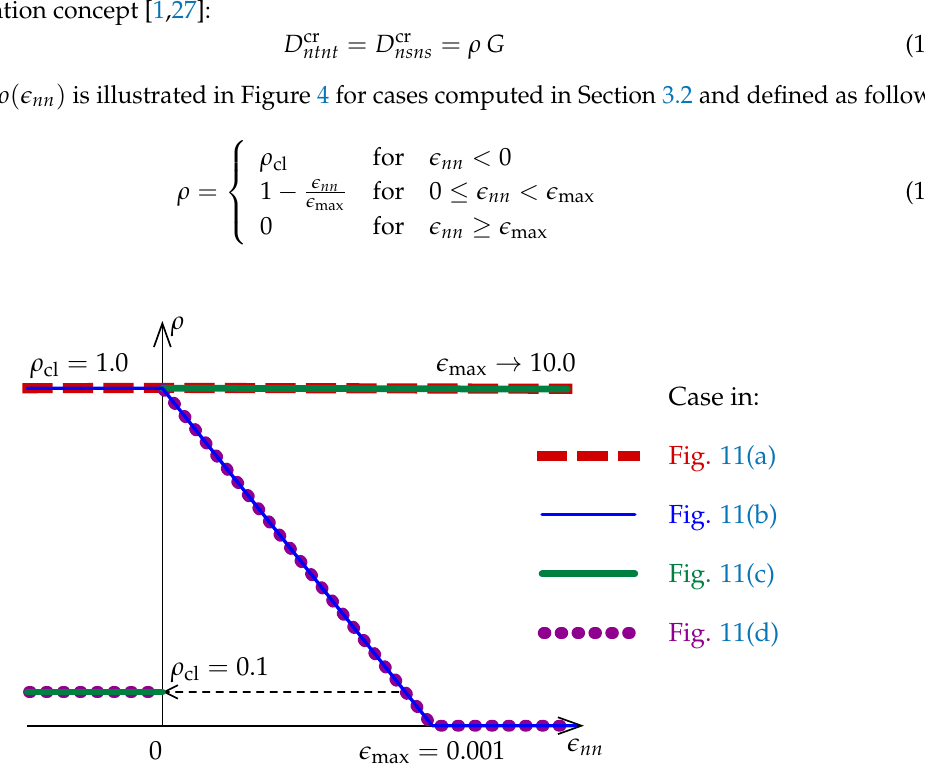
Figure 4. Functions ρ for shear retention effect used in the CSC model (Section